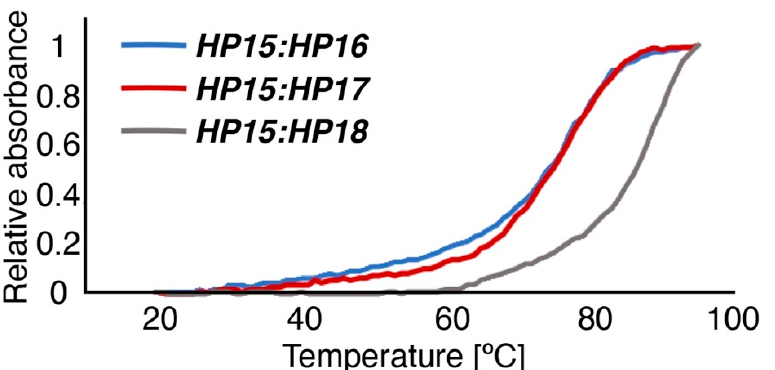
Figure 4. Normalized melting temperature curves shown for the three PNA-hybridization complexes HP15 : HP16 (blue), HP15 : HP17 (red), and HP15 : HP18 (grey). Table 3. 177 Lu-labeling of PNA-based probes and in vitro